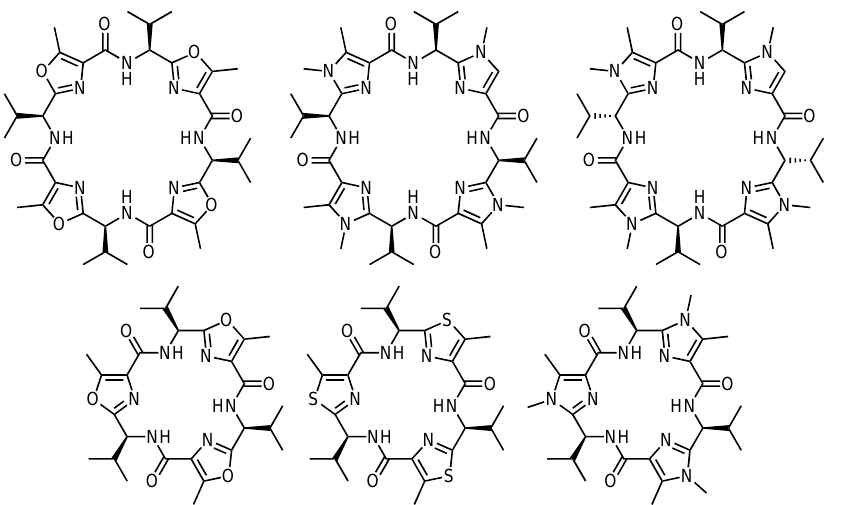
Figure 16. Structures of the ascidiacyclamide analogs 34a – d . The Ca 2+ affinity in 5 vol% water/acetonitrile is specified below each compound with the respective log K a value.